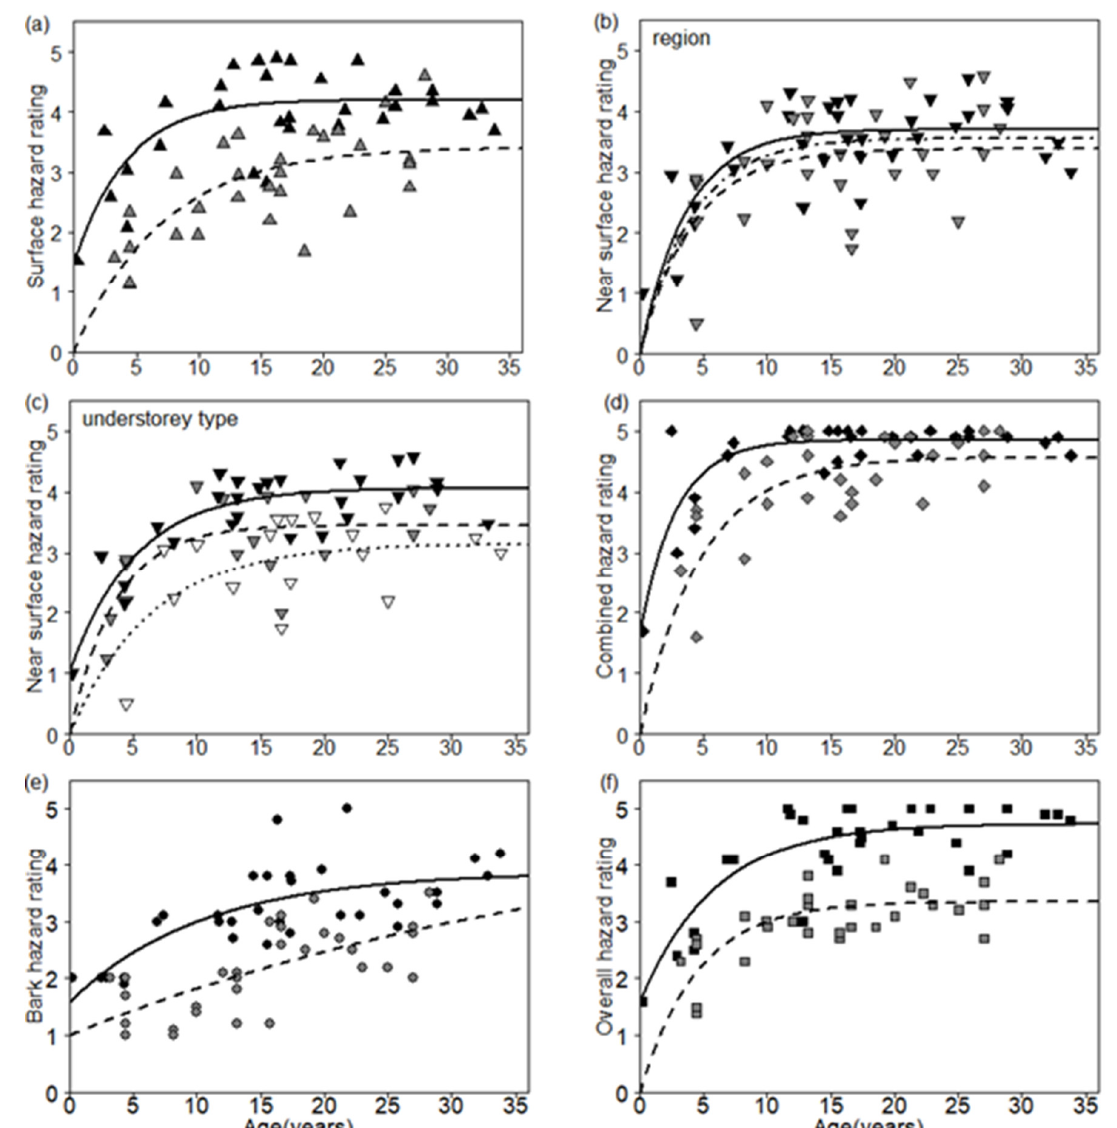
Figure 6. Fuel hazard accumulation curves and data split by region (and understory type for near- surface fuel): ( a ) surface FHR: NE—black triangles and solid line, SE—grey triangles and dash line; ( b ) near-surface FHR by region: NE—black triangles and solid line, SE—grey triangles and dash line, combined region—dot-dash line; ( c ) near-surface FHR by understorey type: litter: open triangles and dotted line, grass: grey triangles and dashed line, heath/bracken: black triangles and solid line; ( d ) combined surface and near-surface FHR: NE—black diamonds and solid line, SE—grey diamonds and dash line; ( e ) bark FHR: NE—black circles and solid line, SE—grey circles and dash line; ( f ) overall FHR: NE sites: black squares and solid line, SE sites: grey squares and dashed line.